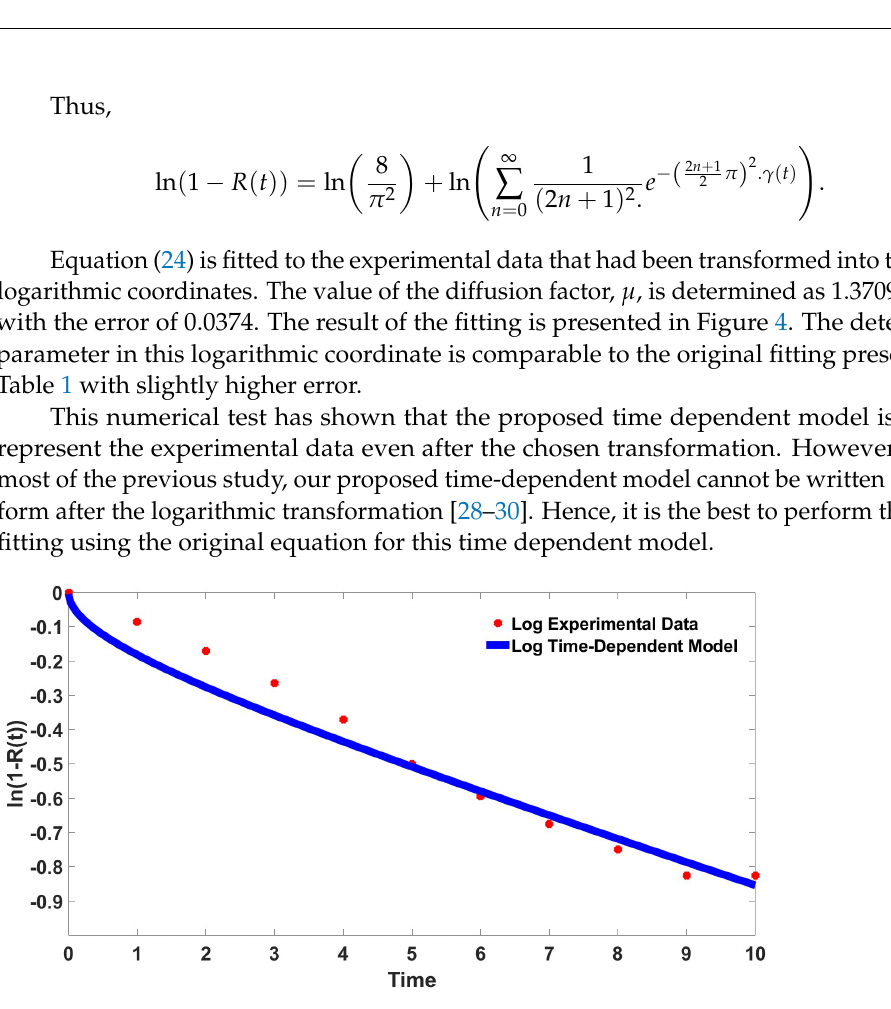
Figure 4. Curve fitting of the transformed fractional drug release data and the time-dependent model in the logarithmic coordinate, ln ( 1 − R ( t ))